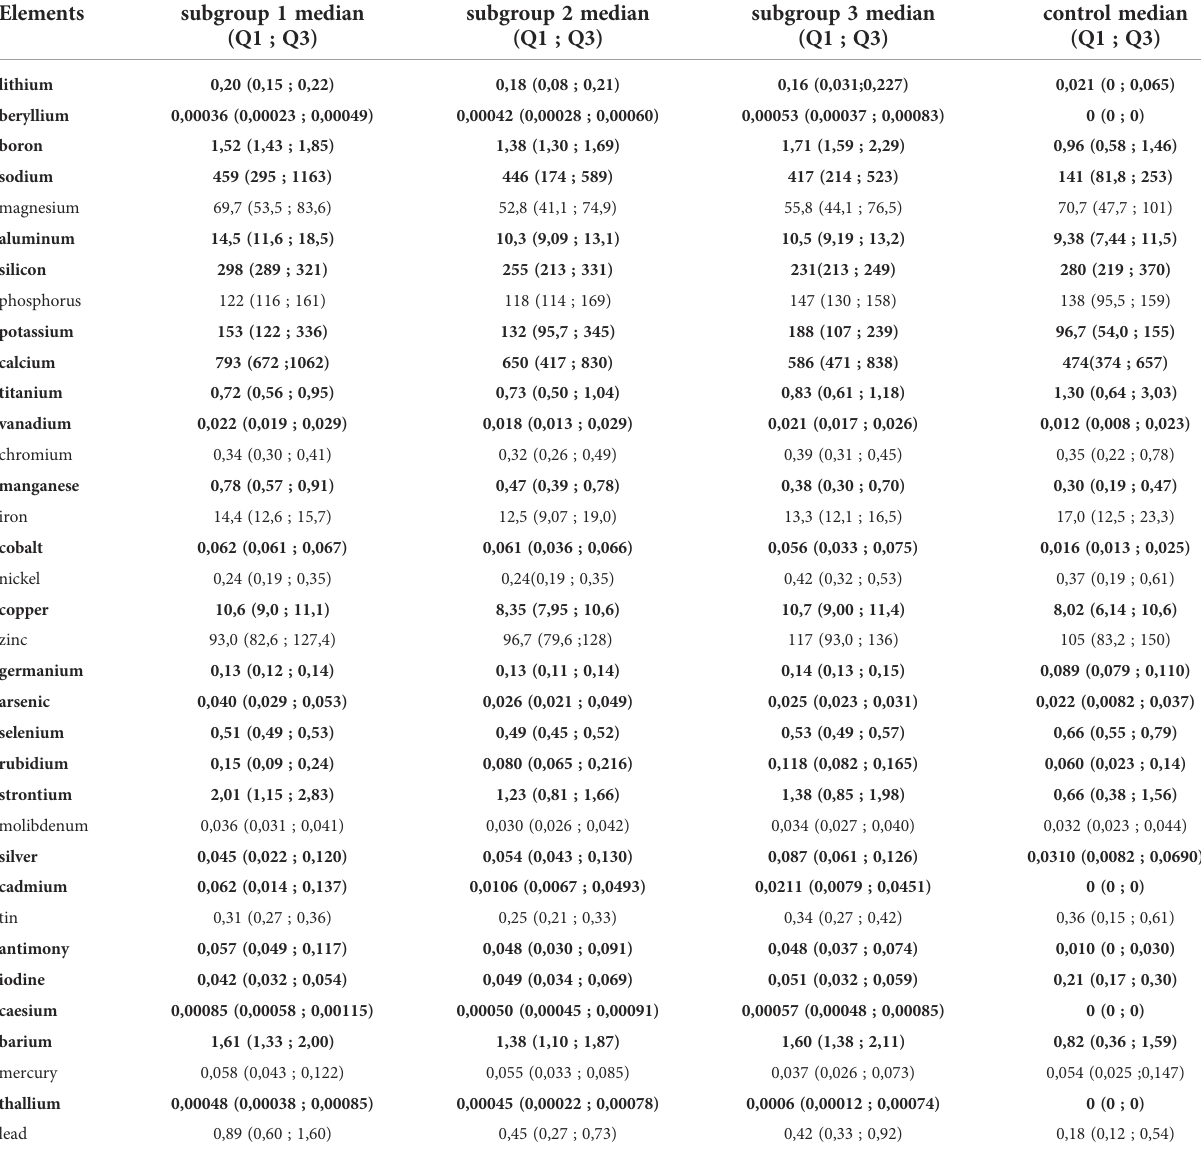
TABLE 1 The content of the analyzed macro- and micro-elements in the hair ( m g/g) of representatives of the experimental (n = 66) and control (n = 92) groups.